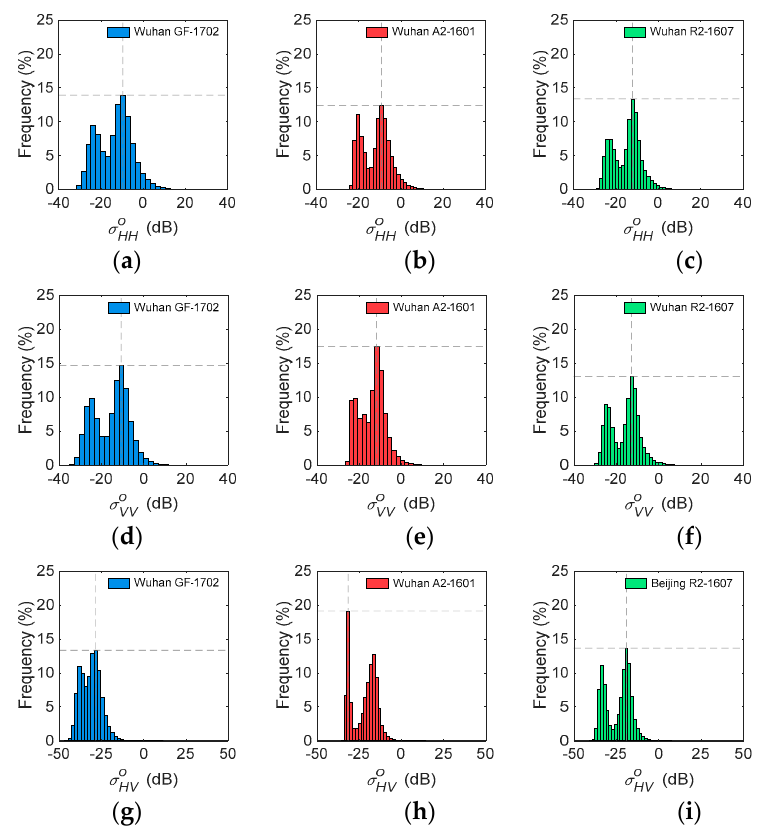
Figure 5. Histograms of GF-1702, A2-1601, and R2-1607 of 𝜎 (cid:3009)(cid:3009)(cid:3042) ( a – c ), 𝜎 (cid:3023)(cid:3023)(cid:3042) ( d – f ), and 𝜎 (cid:3009)(cid:3023)(cid:3042) ( g – i ) in Wuhan.